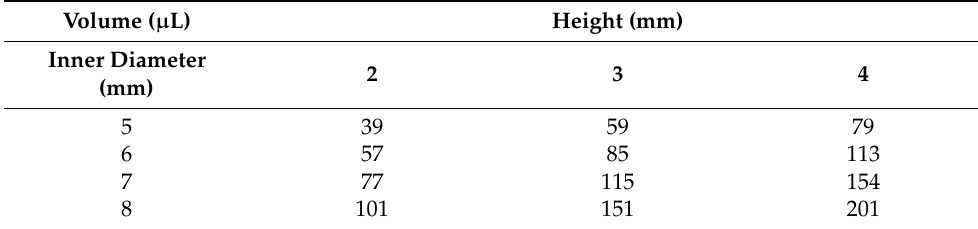
Table 1. Volume of the different Teflon vessels, deduced from the heights and inner radius.